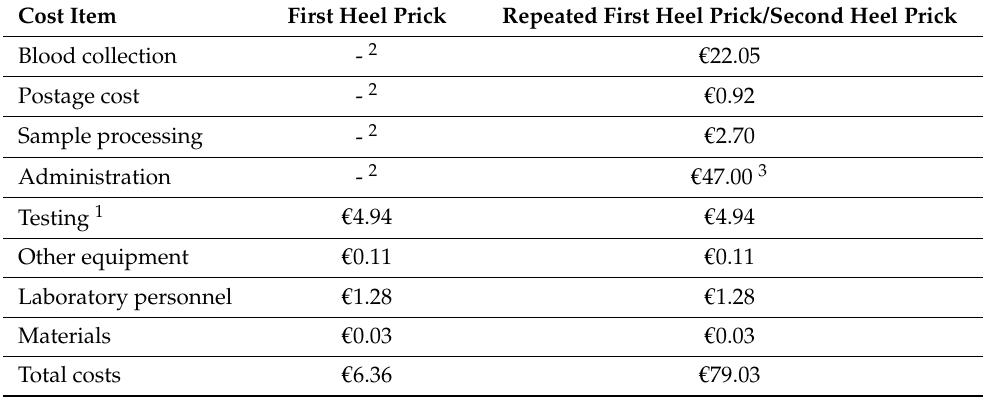
Table 1. Cost of first, repeated first, and second heel prick for severe combined immunodeficiency (SCID) in 2020